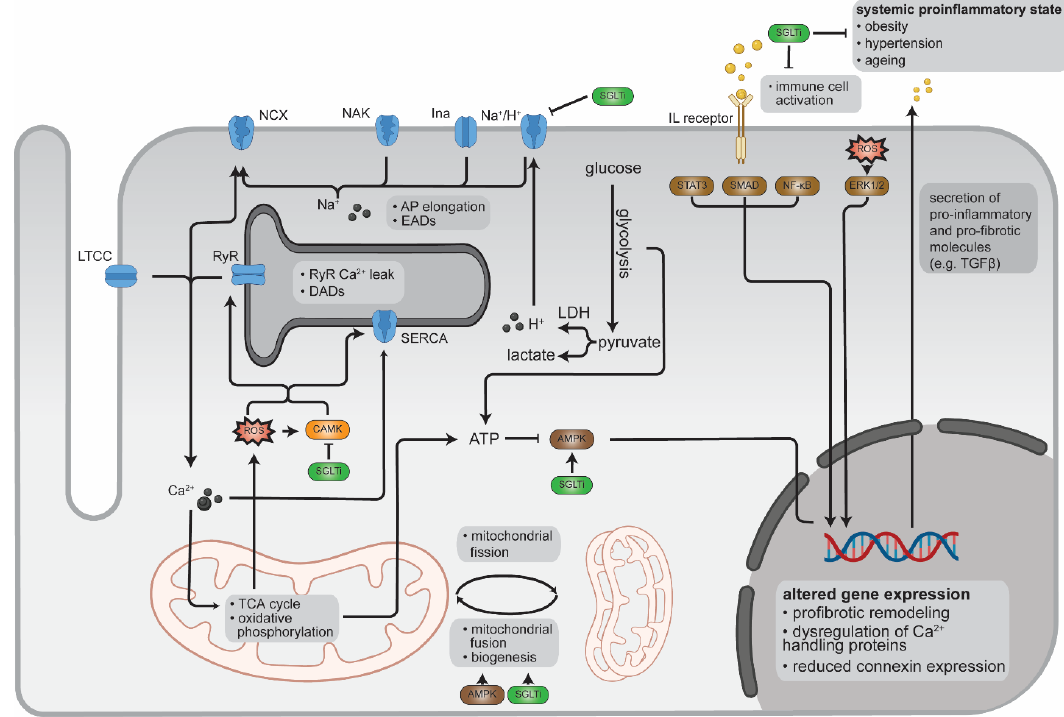
Figure 1. Proposed molecular mechanisms of SGLTi on redox signalling in cardiomyocytes.